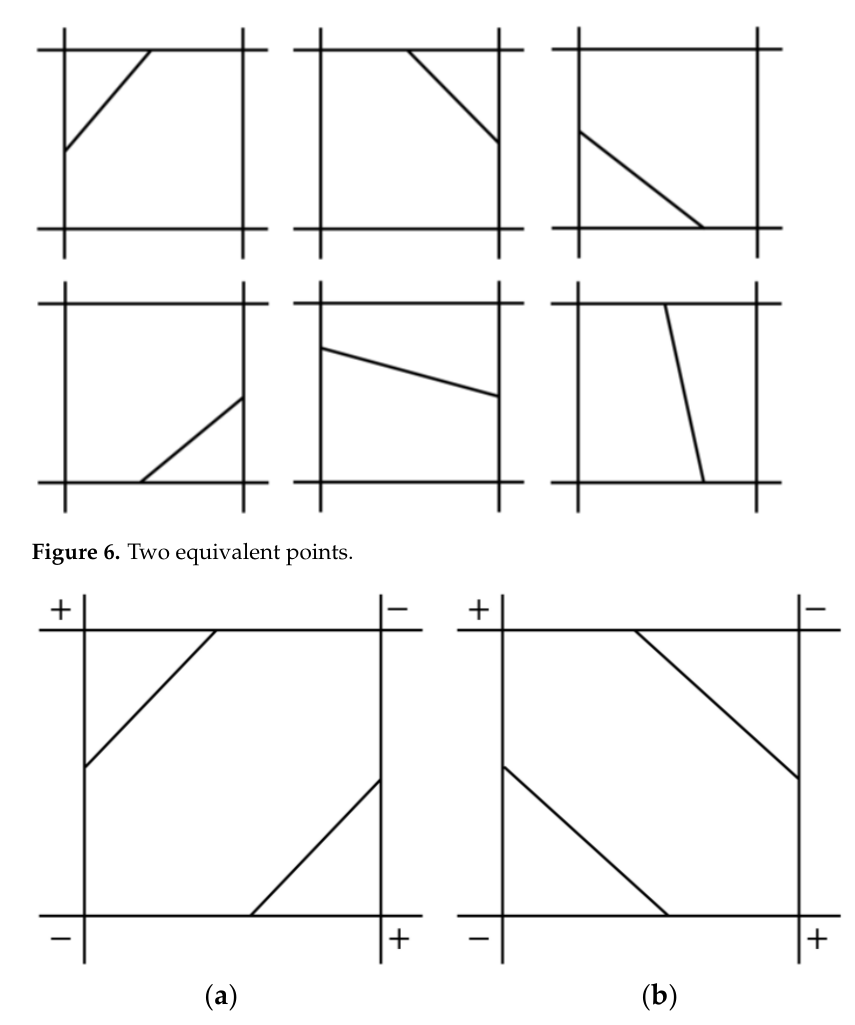
Figure 6. Two equivalent points.